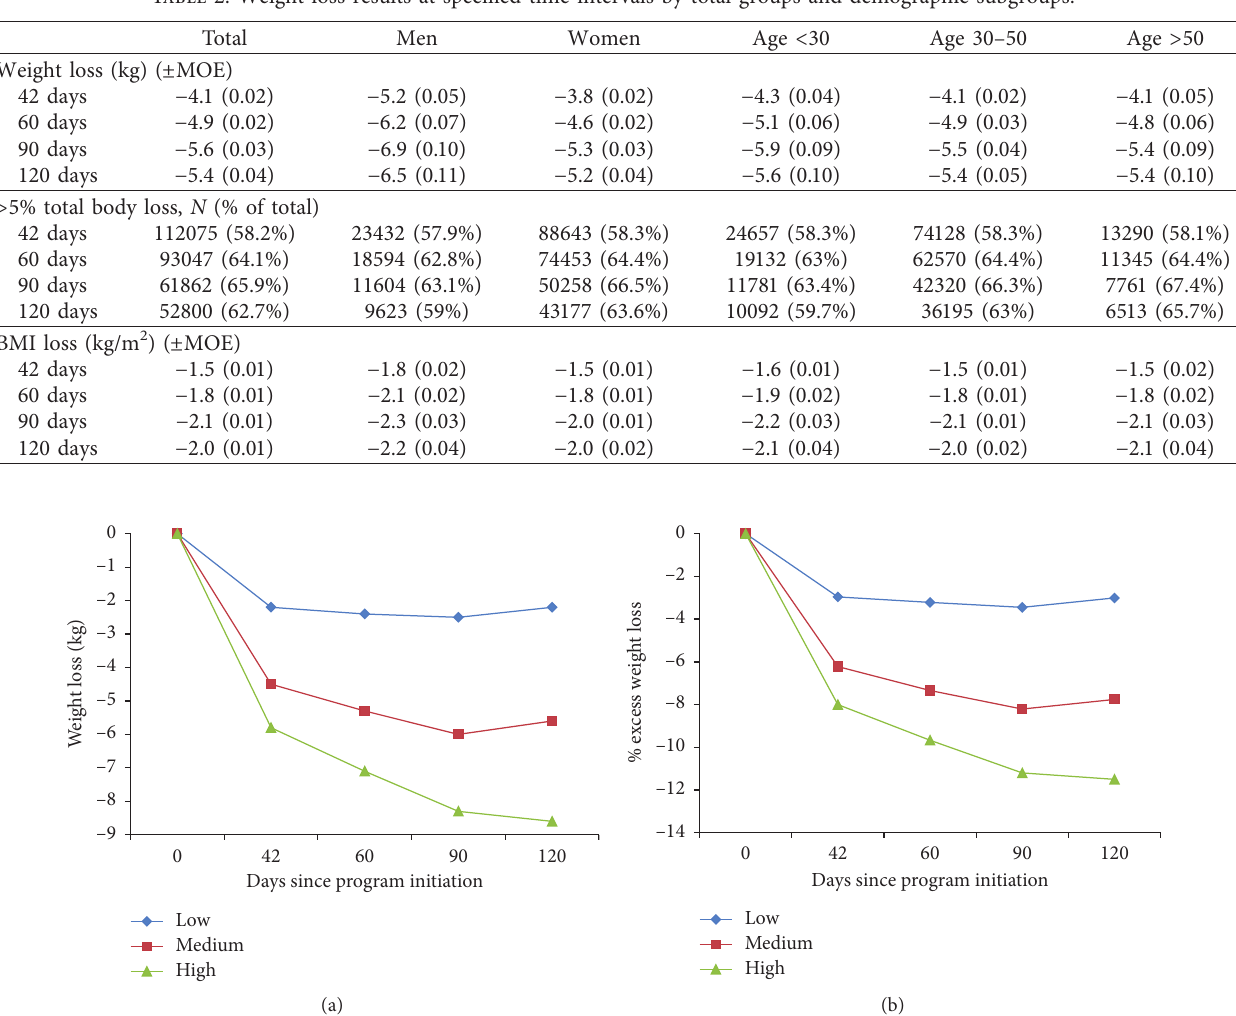
Table 2: Weight loss results at specified time intervals by total groups and demographic subgroups.